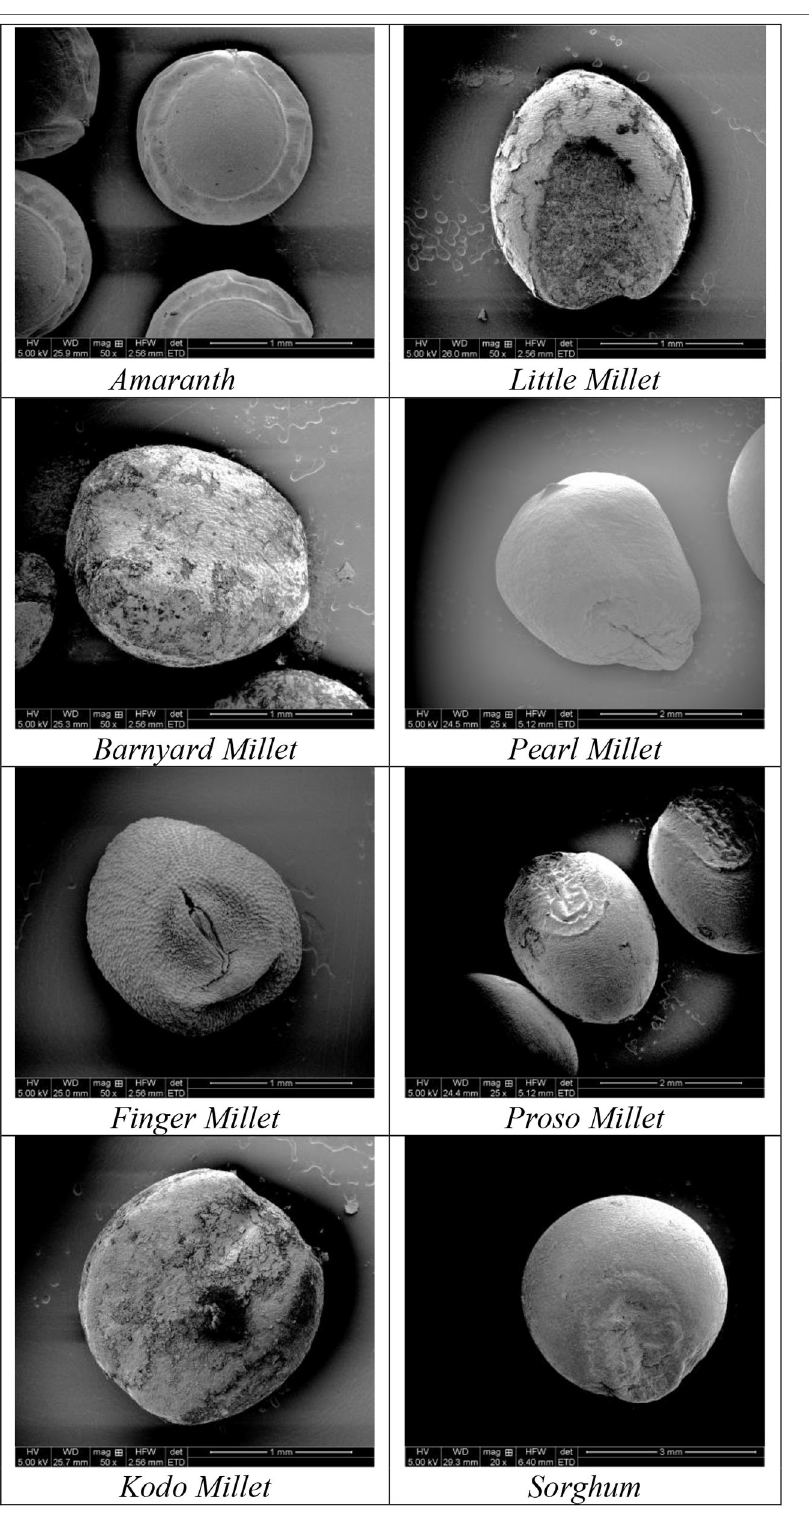
TABLE 5 | Scanning Electron Microscopic (SEM) images of ancient grains: Amaranth, Millets, and Sorghum.